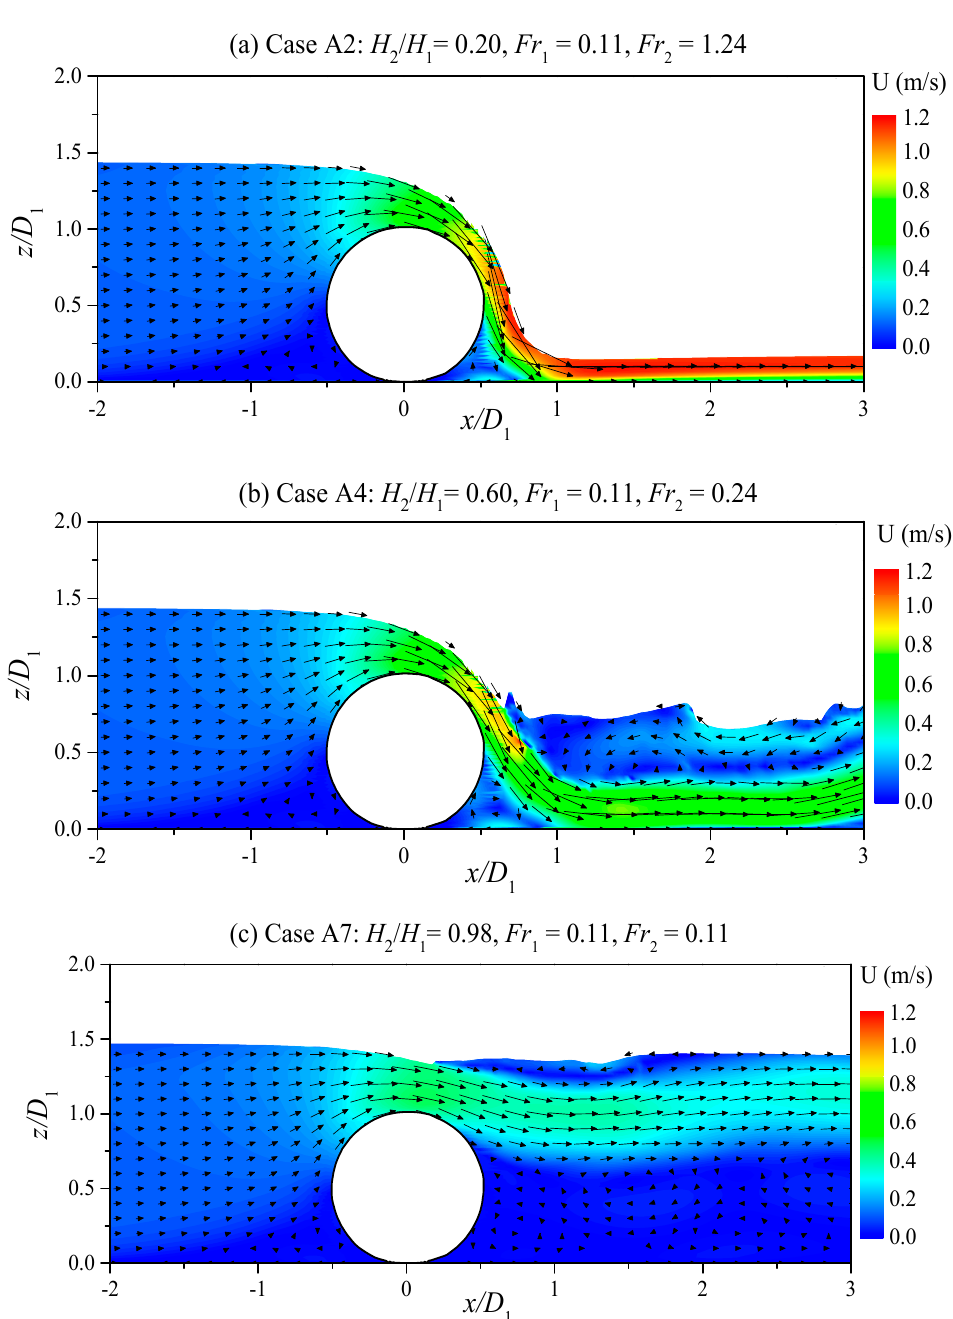
Figure 8. Time-averaged velocity vectors on the mid-plane the circular dam under different downstream depths. ( a ) H 2 / H 1 = 0.2; ( b ) H 2 / H 1 = 0.6; ( c ) H 2 / H 1 = 0.98.